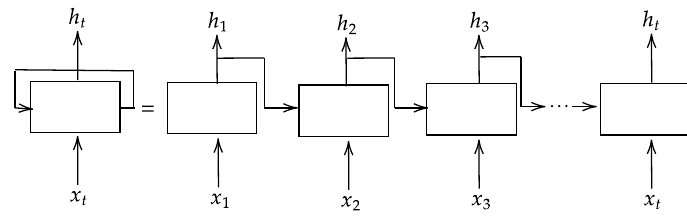
Figure 1. RNN looped and unfolded